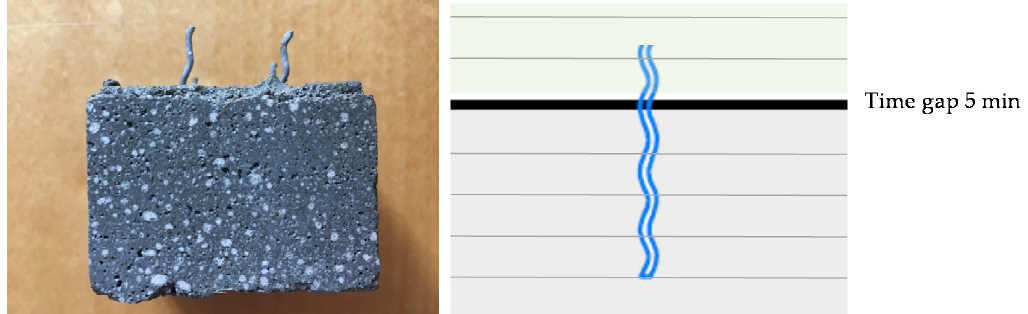
Figure 10. Specimen with vertically inserted fiber reinforcement over cold joints ( left ) and schematically area of fracture ( right ).